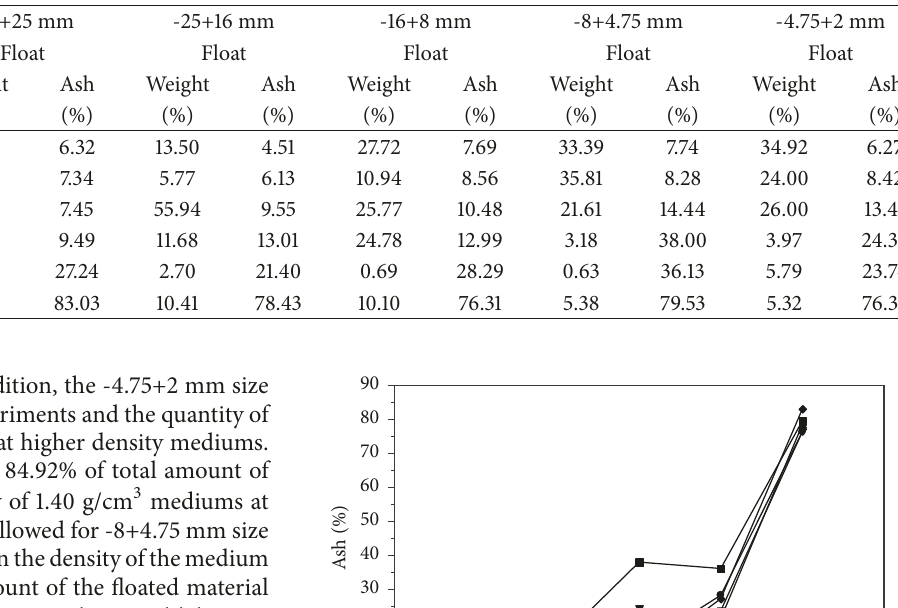
Table 2: The results of float and sink experiments.